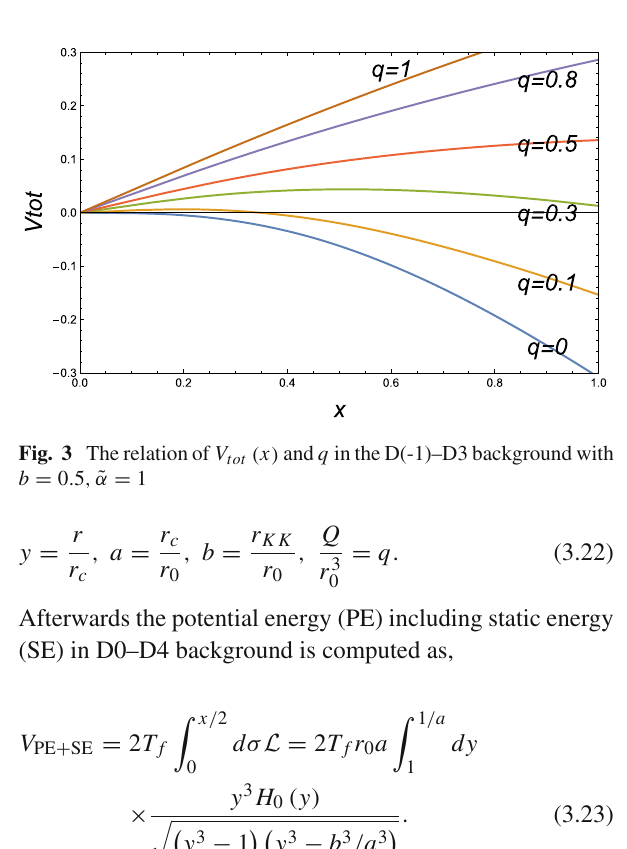
Fig. 2 The dependence on x of the total potential V tot ( x ) with various instanton densities and electric fields (determined by α ) in the confining D(-1)–D3 background. In all graphs we have set b = 0 . 5 and 2 L 2 / r 0 = 2 T f r 0 = 1